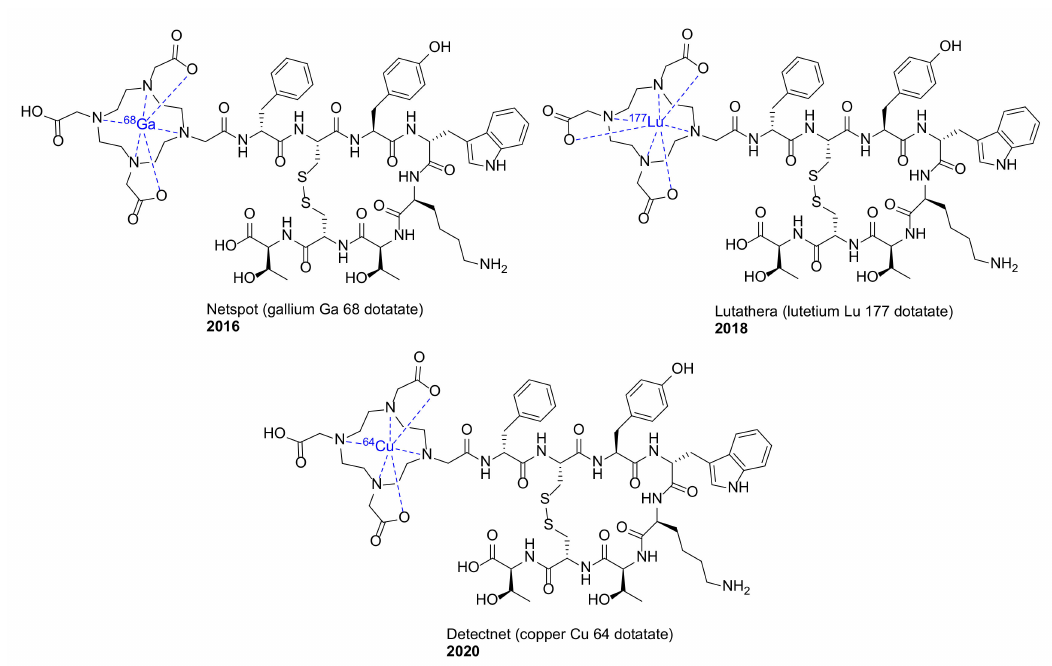
Figure 2. Macrocyclic radiopharmaceuticals approved by the US FDA since